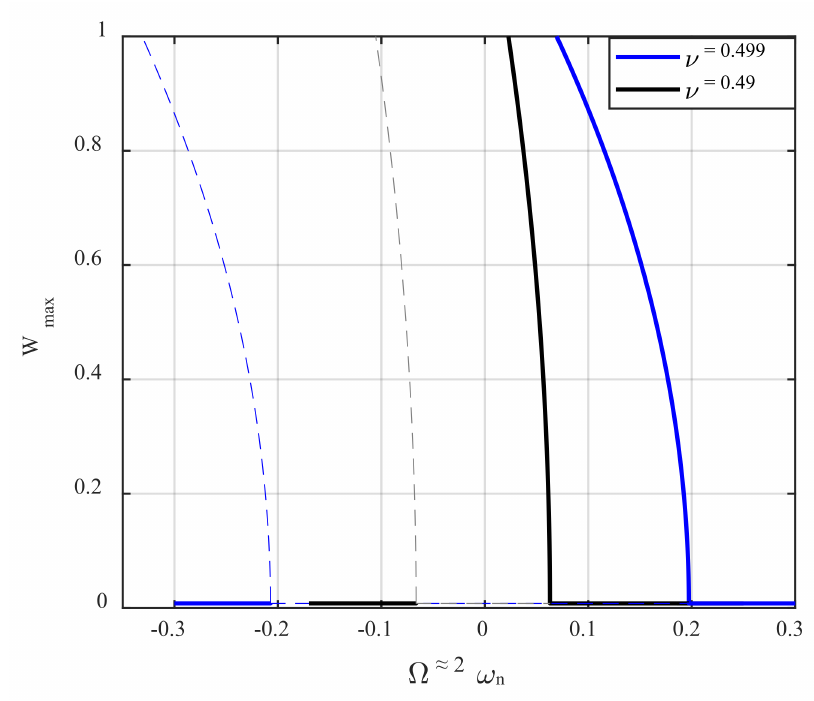
Figure 5. The impact of Poisson’s ratio on the frequency-displacement behavior of the AFM, for d 0 = 0.23 nm. The dashed and solid lines are unstable and stable branches,